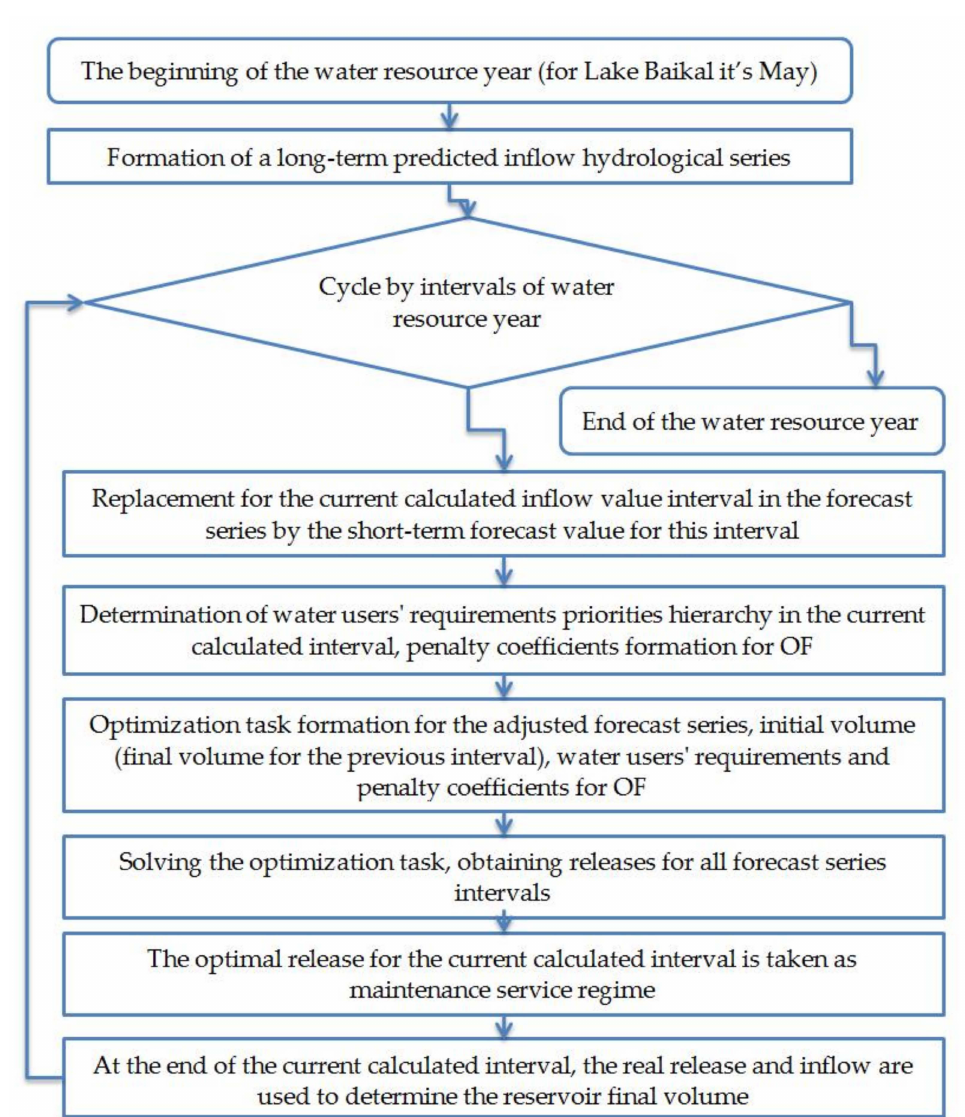
Figure 1. The flowchart of reservoir operating modes formation algorithm in real